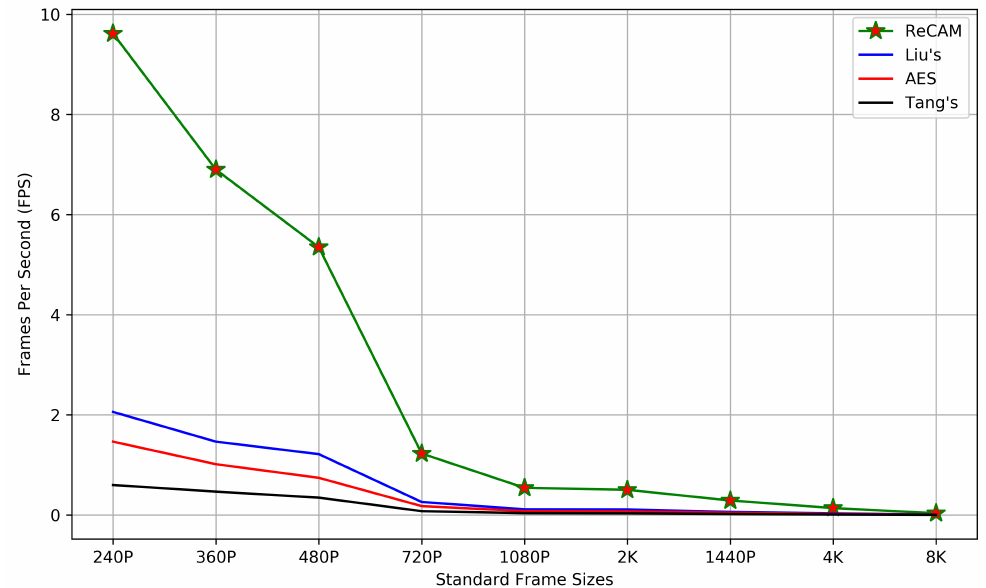
Figure 14. Comparison of the four schemes in terms of frames per second (fps) for different RGB frame sizes: 240 P = 352 × 240 × 3, 360 P = 480 × 360 × 3, 480 P = 640 × 480 × 3, 720 P = 1080 × 720 × 3, 1080 P = 1920 × 1080 × 3, 2 K = 2048 × 1080 × 3, 1440 P = 2560 × 1440 × 3, 4 K = 3840 × 2160 × 3, and 8 K = 7680 × 4320 ×